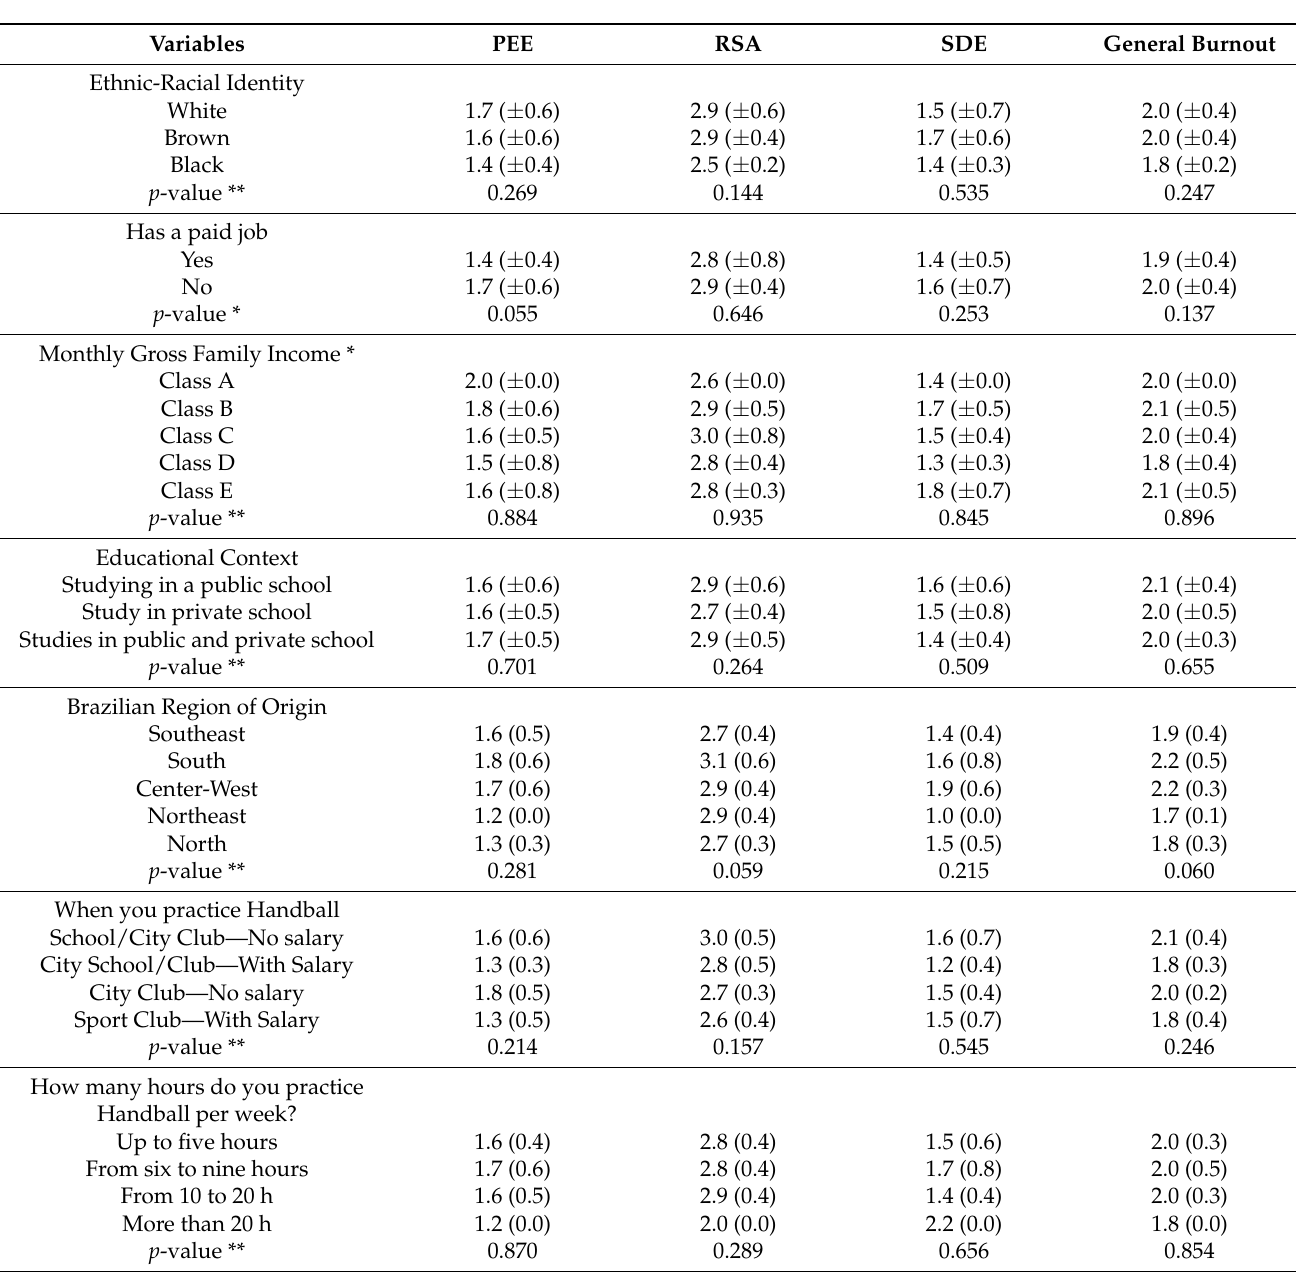
Table 3. Distribution of the mean scores for ABQ dimensions and general burnout, according to athletes’ sociodemographic and professional